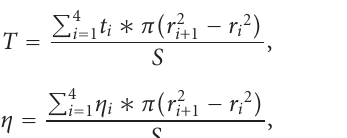
where T is the average transmittance of monochromatic light in (5); η is the average concentration e ffi ciency of monochro- matic light in (6); t i and η i are the average transmittance and concentration e ffi ciency in the ring area from radius r i to r i +1 , respectively; S represents the area of a circle of radius 70 mm. r 1 = 0; r 2 = 10; r 3 = 30; r 4 = 50; r 5 = 70. The